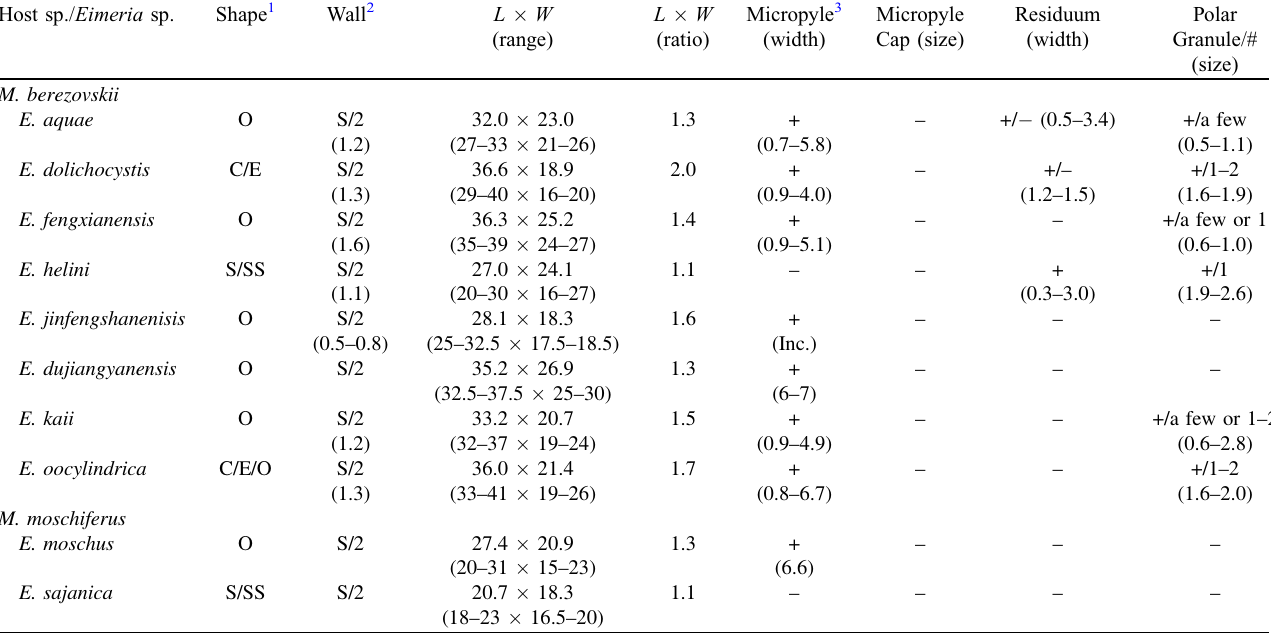
Table 1. De fi ning structural characters of the sporulated oocysts of all Eimeria species known from all seven musk deer species (Moschidae: Moschus spp.)